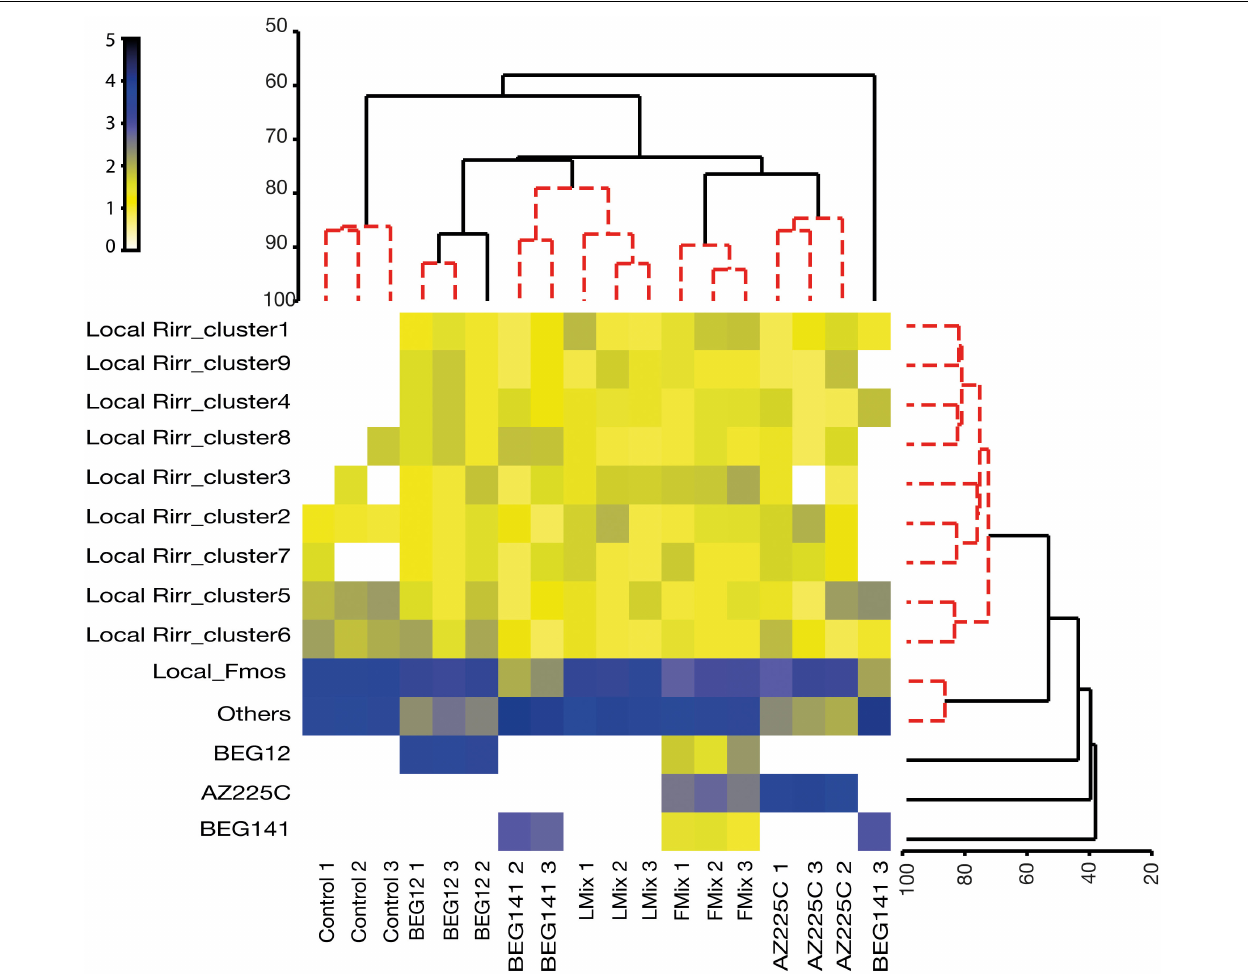
FIGURE 5 | Dendrogram of Similarity Profile (SIMPROF) cluster analysis (horizontal dendrogram) grouping the different samples collected at the beginning of spring growth (roots of 2-year alfalfa, M. sativa ) [three fields replicate plots treated by mock-inoculated control (Control), F. mosseae isolates BEG12 and AZ225C, R. irregularis isolate BEG141, foreign mixture-FMix (BEG12, AZ225C, and BEG141), local mixture-LMix of 14 AM fungal species belonging to five families] into clusters based on their similarity/homogeneity of AM fungal intraradical communities [relative abundances of phylotypes of non-native/inoculated F. mosseae BEG12 and AZ225C, non-native/inoculated R. irregularis BEG141, native F. mosseae (Local Fmos) and native R. irregularis (Local Rirr_cluster1-9) and other Glomeromycota taxa (others)]. Vertical dendrogram groups the different phylotypes based on their similarity of occurrence. Red clusters are supported by the SIMPROF analysis. Relative abundance input data were log(X + 1) transformed and Bray-Curtis similarity was calculated and shown as a shaded